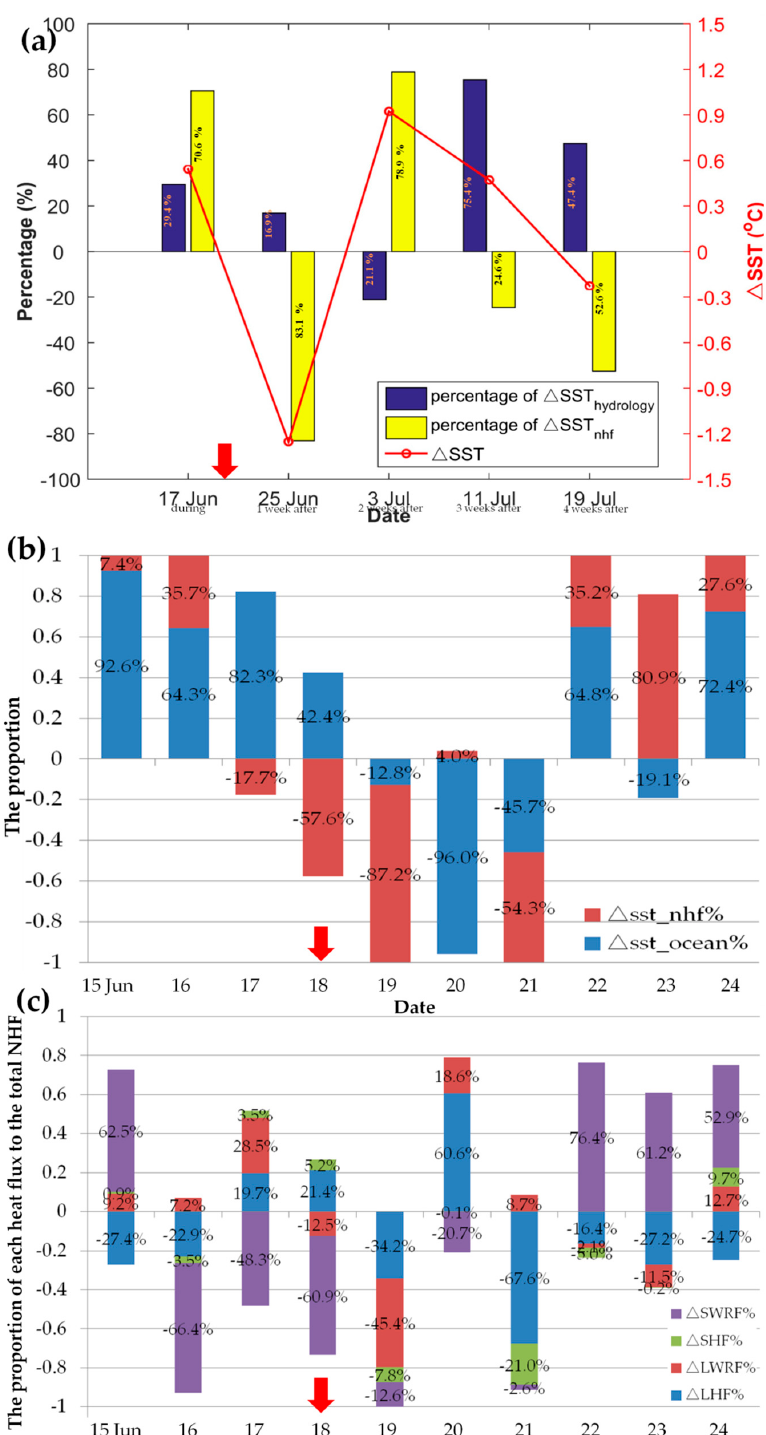
Figure 9. Study area averaged heat budget analysis to the changes of the sea surface temperature ( △ SST) before and after the typhoon. ( a ) The weekly area average △ SST due to net heat flux (NHF) and the ocean processes. ( b ) The daily area average △ SST due to NHF and the ocean processes. ( c ) The proportion of the daily area average heat flux differences (sensible heat flux (SHF), latent heat flux (LHF), longwave radiation flux (LWRF), and shortwave radiation flux (SWRF)) to the total daily area averaged NHF. The red arrows represented the passing time of the typhoon Linfa. Positive values mean increase of the SST and negative values mean decrease of the SST.